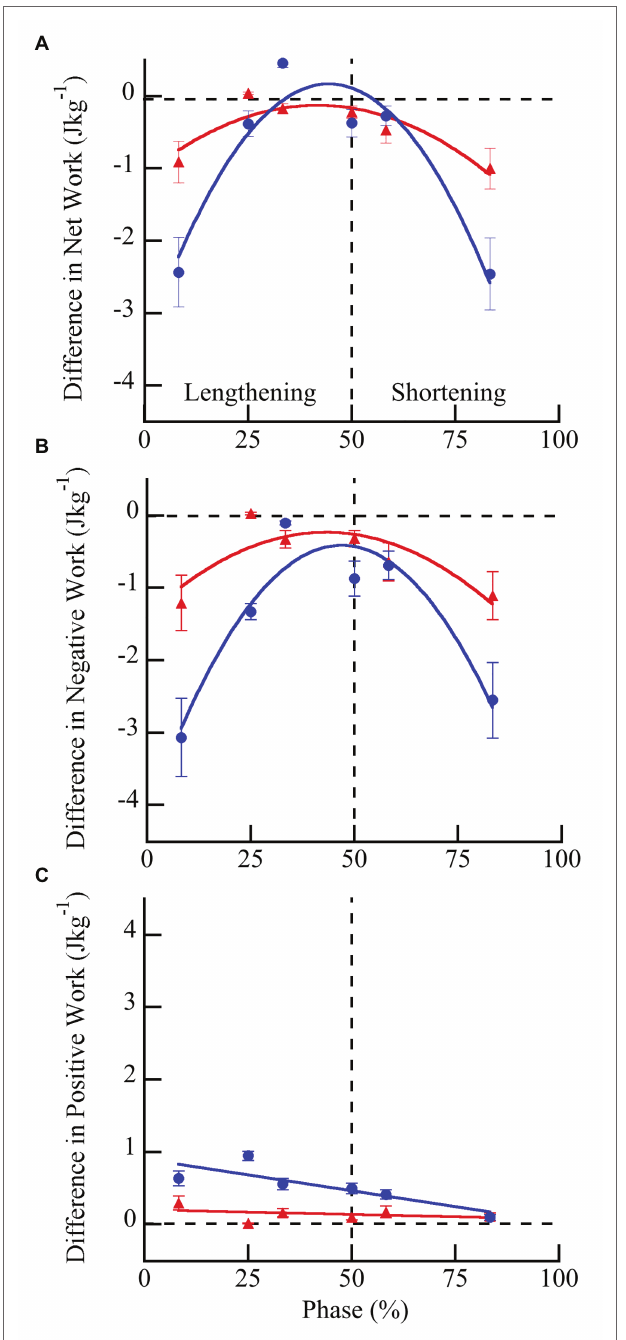
FIGURE 5 | Differences in net (A) , negative (B) , and positive (C) work per cycle with vs. without doublet stimulation across phase of activation in wild type (blue) and mdm (red) muscles. The greatest increase in work with doublet stimulation occurred when muscles were activated during lengthening and the smallest increase occurred when muscles were activated during shortening. Wild type muscles exhibited a significantly greater increase in net ( F = 43.84, p < 0.0001), negative ( F = 14.51, p = 0.007), and positive ( F = 50.43, p < 0.0001) work than mdm muscles across all phases of activation. Phase = 0% indicates a muscle at its shortest length at the onset of lengthening and phase = 50% indicates a muscle at its longest length just prior to shortening. Data represent means ± SE, N = 28 individuals, 112 trials.